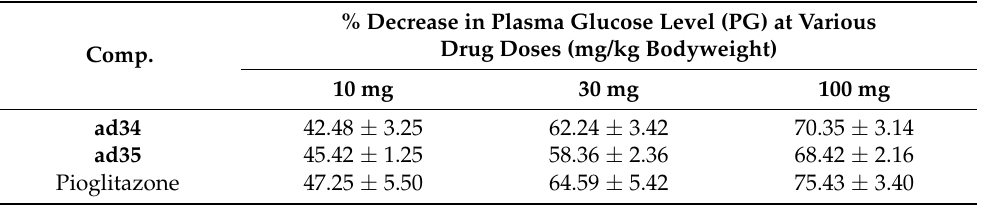
Table 45. Antidiabetic potential of the compounds (ad34 – ad35) in alloxan-induced diabetes in rats.